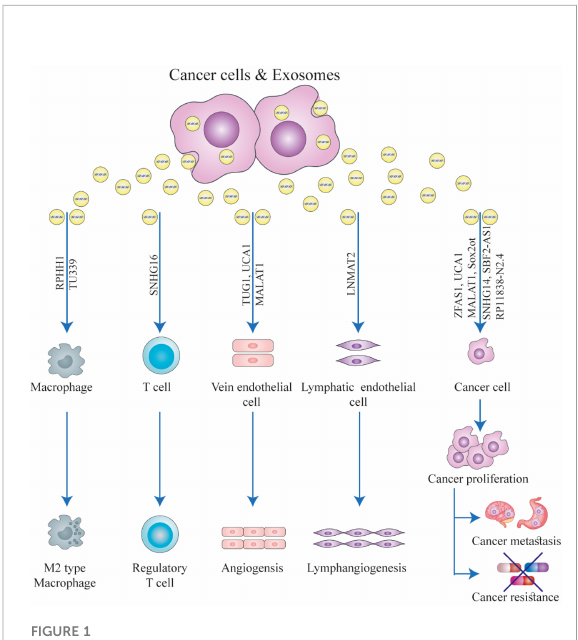
FIGURE 1 The function of exosomal long non-coding RNAs (lncRNAs) in the biology of cancer. Exosomes can facilitate interactions between stromal cells, immune cells, and cancer cells in the tumor microenvironment. Exosomal lncRNAs secreted from cancer cells can induce drug resistance, immunological regulation, angiogenesis, cancer growth, and metastasis in recipient cells. This fi gure was adapted from Zhang et al.